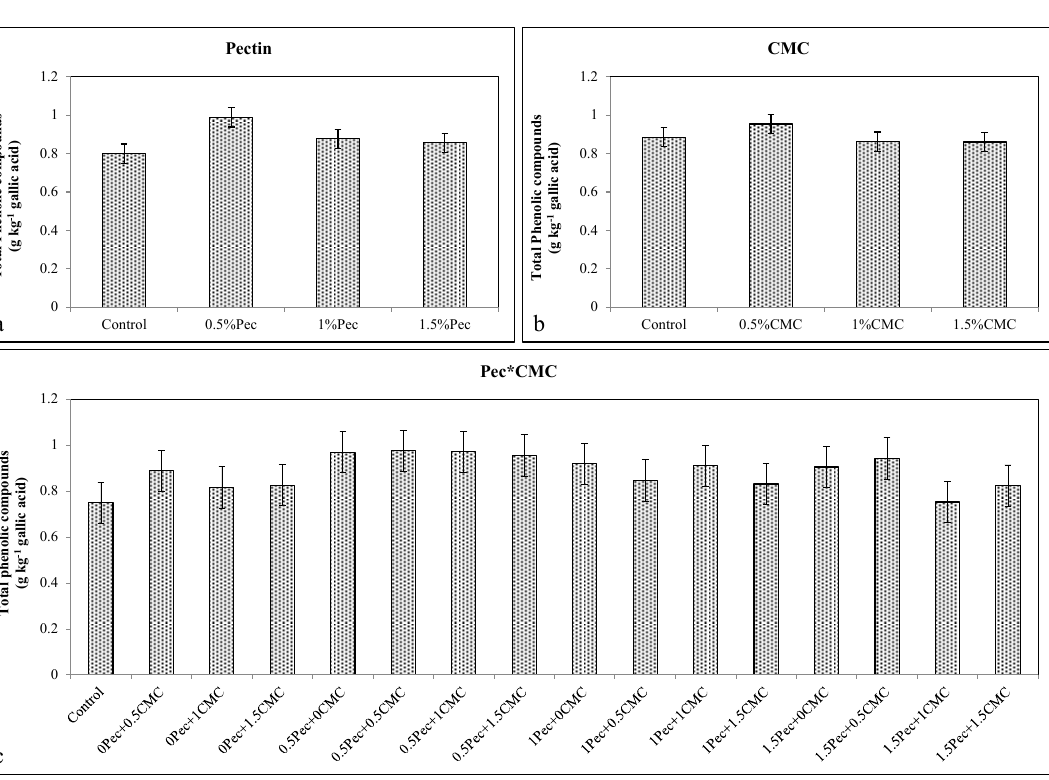
Figure 6. Effect of 0 (control), 0.5 (0.5% Pec), 1 (1% Pec) and 1.5 (1.5% Pec) % pectin-based edible coatings ( a ), 0 (control), 0.5 (0.5% CMC), 1 (1% CMC) and 1.5 (1.5% CMC) % carboxymethylcellulose-based edible coatings ( b ) and their combinations ( c ) on total phenolic compounds during cold storage period. Data are the “estimated marginal means ±95% confidence intervals”. The results were expressed on a fresh weight basis. The columns with non-overlapping error bars are significantly different ( p ≤ 0.05).